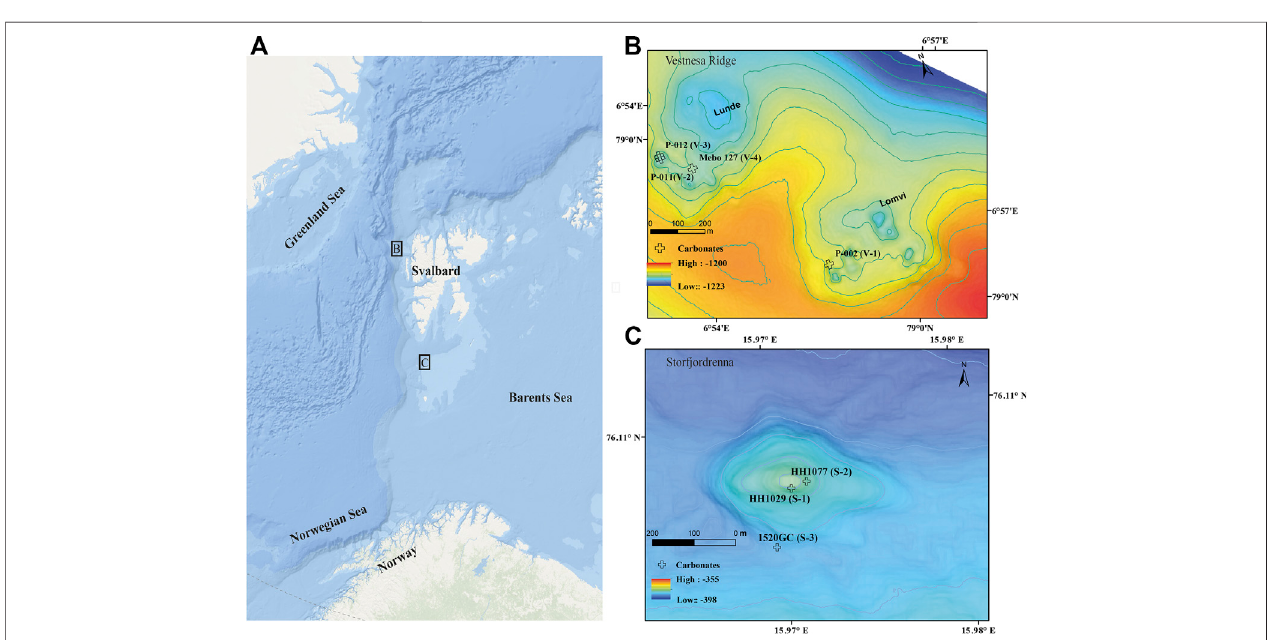
FIGURE1|(A) OverviewofsamplinglocationsatVestnesaRidgeoffNWSvalbard,andStorfjordrennagashydratemoundintheNWBarentsSea(Arcticbasemap from ArcGIS). (B,C) Detailed bathymetry maps and respective seep carbonate sample locations.